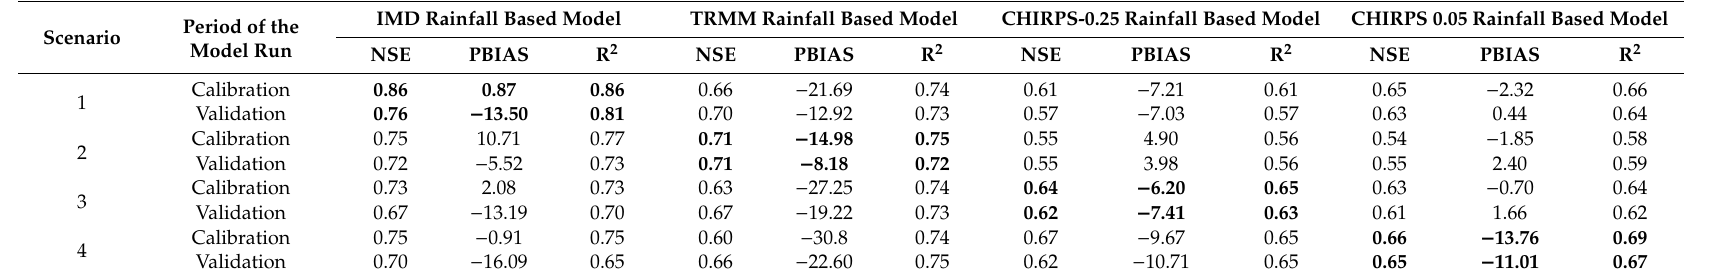
Table 4. Statistical indexes for Gurupura streamflow using di ff erent rainfall